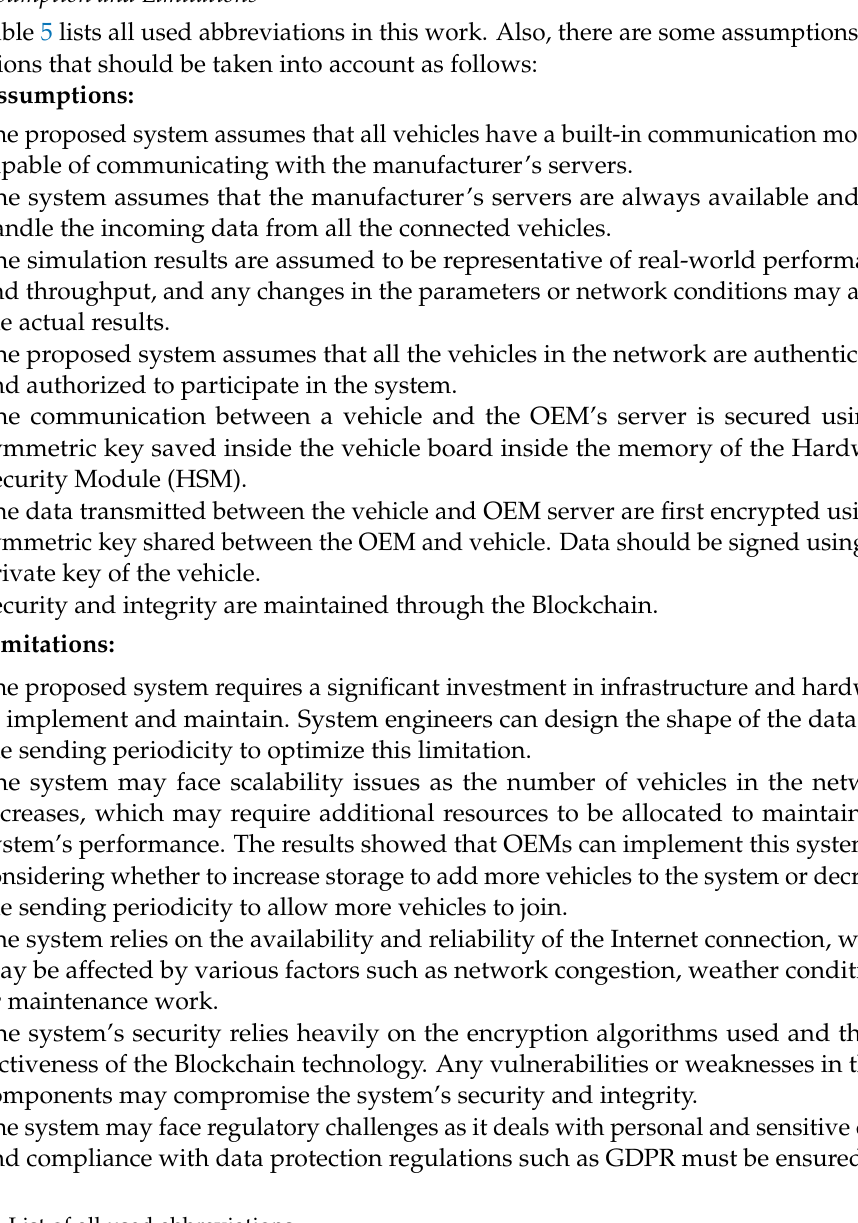
Table 5. List of all used